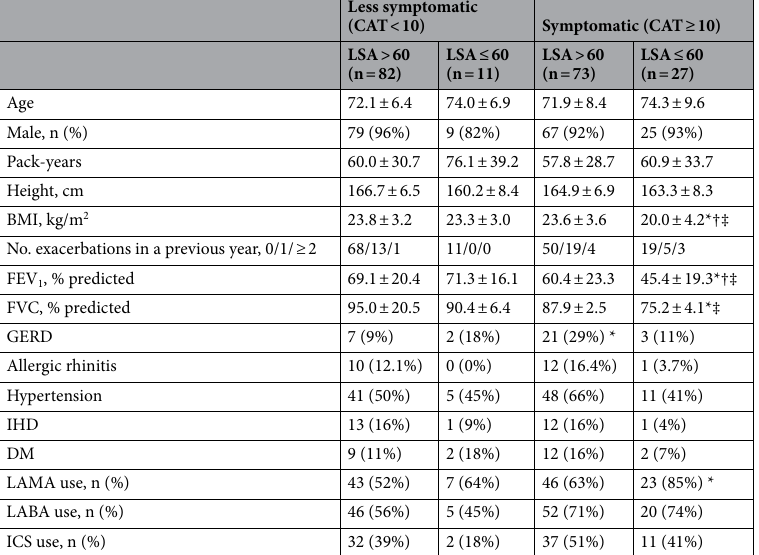
Less symptomatic (CAT <